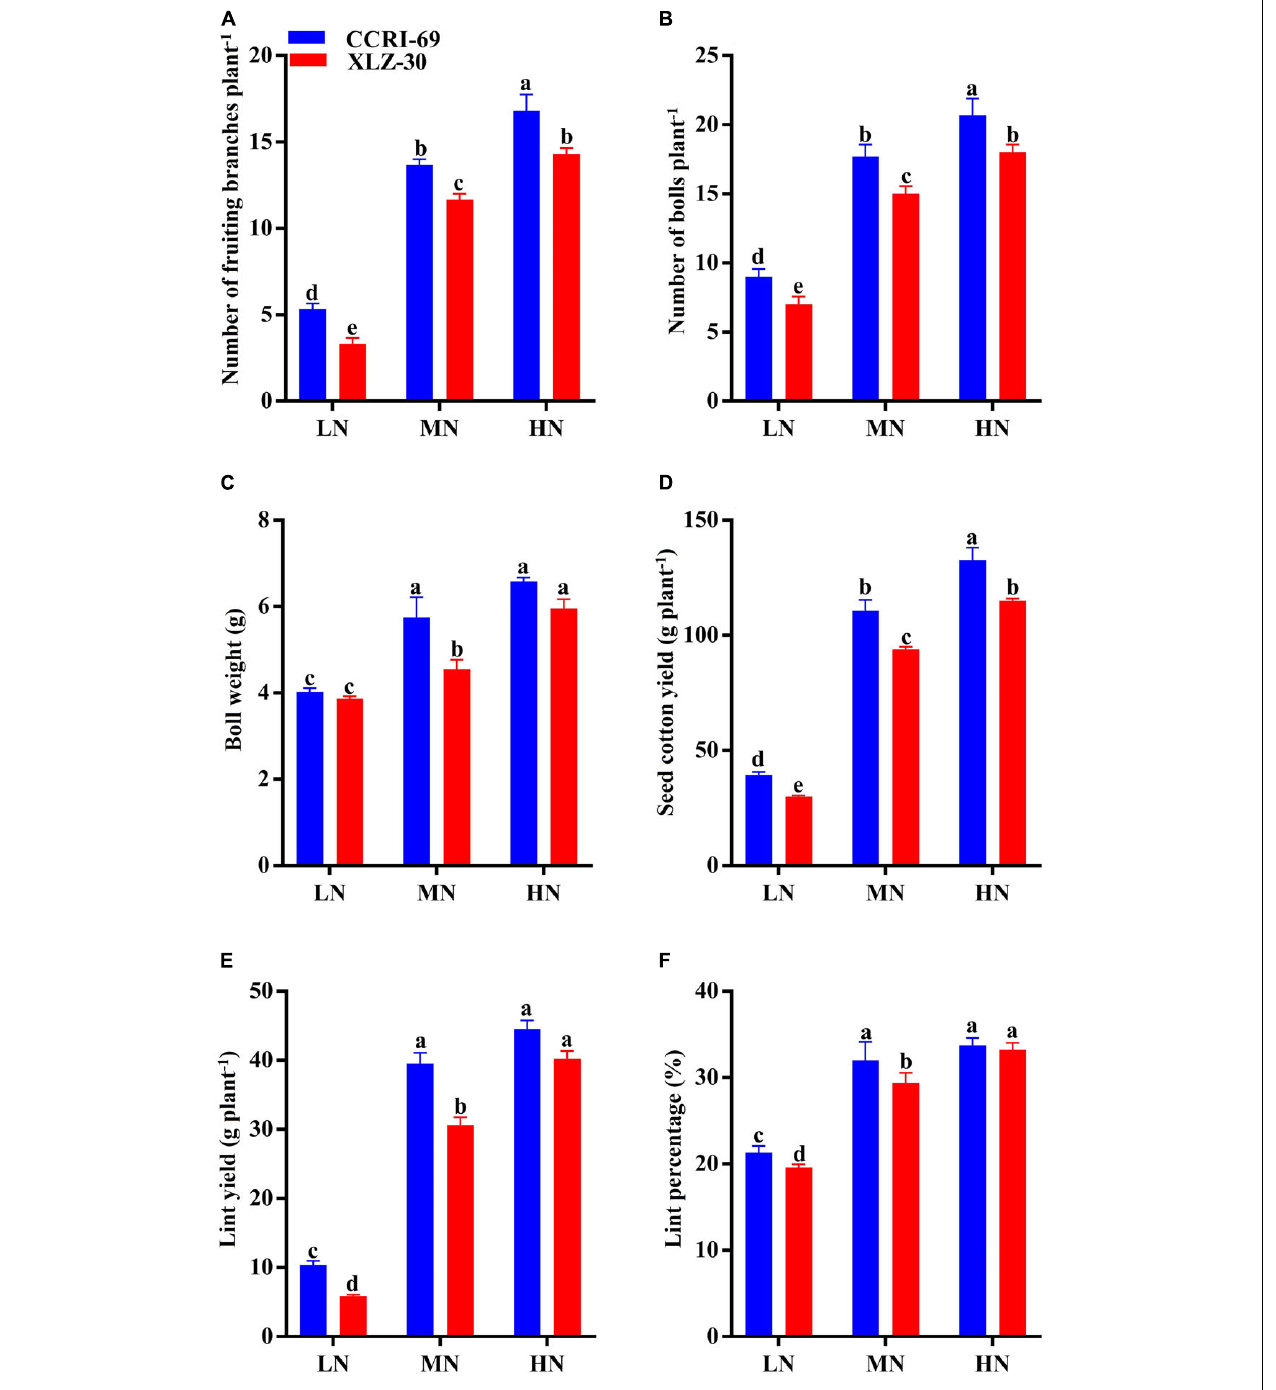
FIGURE 6 | (A–F) Number of fruiting branches plant − 1 , number of bolls plant − 1 , boll weight (g), seed cotton yield (g plant − 1 ), lint yield (g plant − 1 ), and lint percentage (%) of CCRI-69 and XLZ-30 in response to low (LN; 0.25 mM), moderate (MN; 2.5 mM), and high (HN; 5 mM) N levels. Error bars with different small letters show significant differences between genotypes under different N levels ( p <